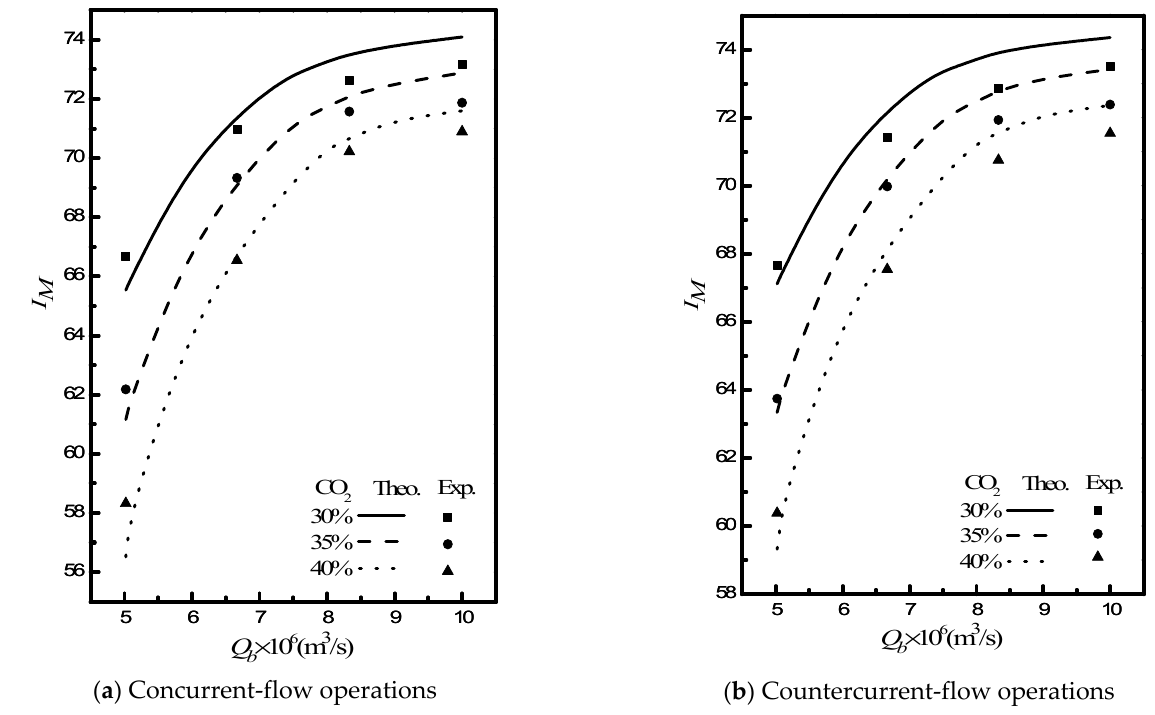
Figure 9. Comparisons of CO 2 absorption efficiency with various operating parameters. The effect of the operating parameters investigated on the absorption efficiency in- cludes gas and absorbent flow rates, inlet CO 2 concentration, and flow patterns. Figure 10 illustrates the CO 2 absorption efficiency I M varies with mass-transfer Graetz number Gz b with inlet CO 2 concentrations and gas feed rates as parameters under both concurrent- and countercurrent-flow operations. The lower gas flow rate results in the higher absorption efficiency due to having a longer resident time in contact with the membrane surface. The CO 2 absorption efficiency increases with decreasing the inlet CO 2 concentra- Gz due to balancing the chemical reaction equi- tion and mass-transfer Graetz number a librium and saturated CO 2 concentration. The theoretical results indicate that the CO 2 ab- sorption efficiency in countercurrent-flow operation is higher than that in concurrent-flow operations, as illustrated in Figures 7–10, because the driving-force of the CO 2 concentra- tion gradient between both gas and absorbent phases is greater in countercurrent-flow operations than that in concurrent-flow operations, as confirmed in Figure 5.